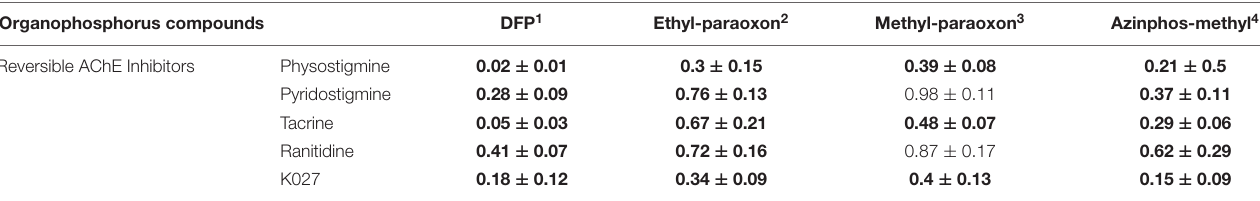
TABLE 6 | Protective efficacy of K027 and reversible AChE inhibitors (physostigmine, pyridostigmine, tacrine, ranitidine) administered prophylactically before exposure to the OPCs ethyl-paraoxon = paraoxon, methyl-paraoxon or azinphos-methyl. Organophosphorus